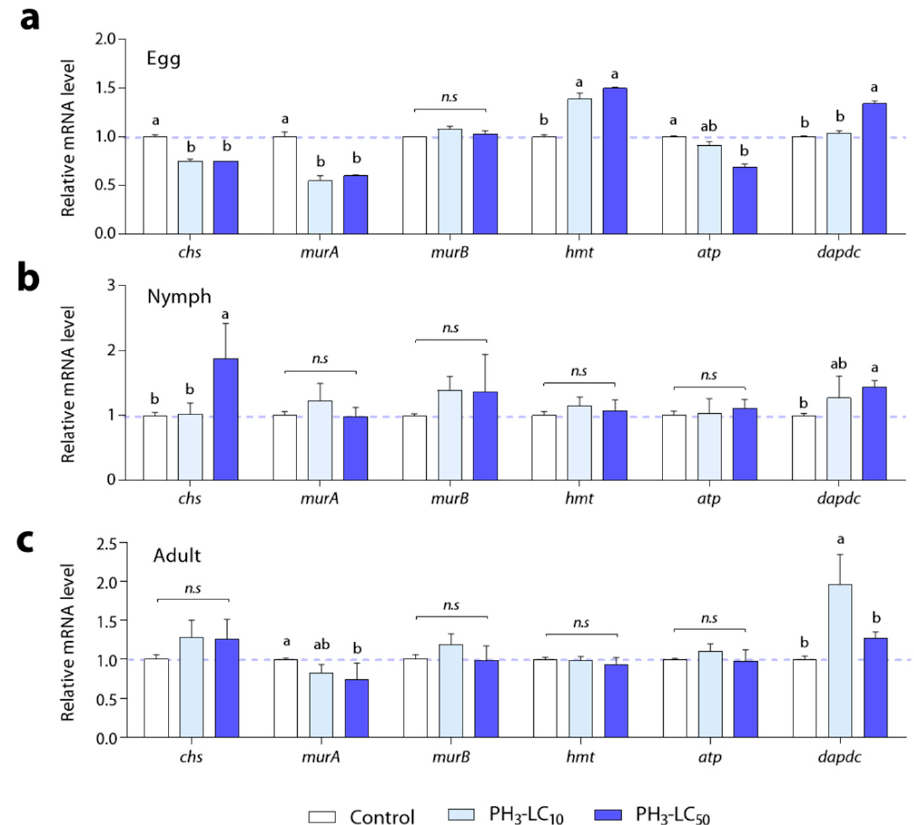
Figure 4. Gene expression levels of exposure to lethal concentration LC 10 and LC 50 values of phosphine (PH 3 ) for 20 h on P. citri developmental stages. Relative gene expressions of eggs ( a ), nymphs ( b ), and adults ( c ) were normalized using the expression level of glyceraldehyde-3-phosphate. Gene abbreviations were as follows: chitin synthase (chs), UDP-N-acetylglucosamine enolpyruvoyl transferase (murA), UDP-N-acetylenolpyruvoylglucosamine reductase (murB), homocysteine S- methyltransferase (hmt), V-ATPase (atp), and diaminopimelate decarboxylase (dapdc). Data were analyzed using one-way ANOVA, followed by post hoc Tukey’s tests. Different lowercase